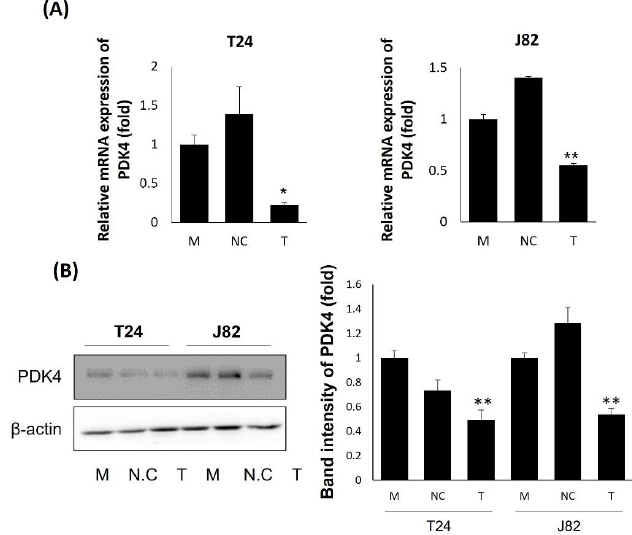
Figure 1. Expression of PDK4 in siRNA-treated bladder cancer cell lines. ( A ) Fold change of PDK4 mRNA expression in T24 and J82 cells. ( B ) Protein expression of PDK4 in T24 and J82 cells. All data represent means ± SD of three independent experiments (* p < 0.05, ** p < 0.01 NC vs. T). M: mock, N: negative control, T: PDK4 siRNA treated.